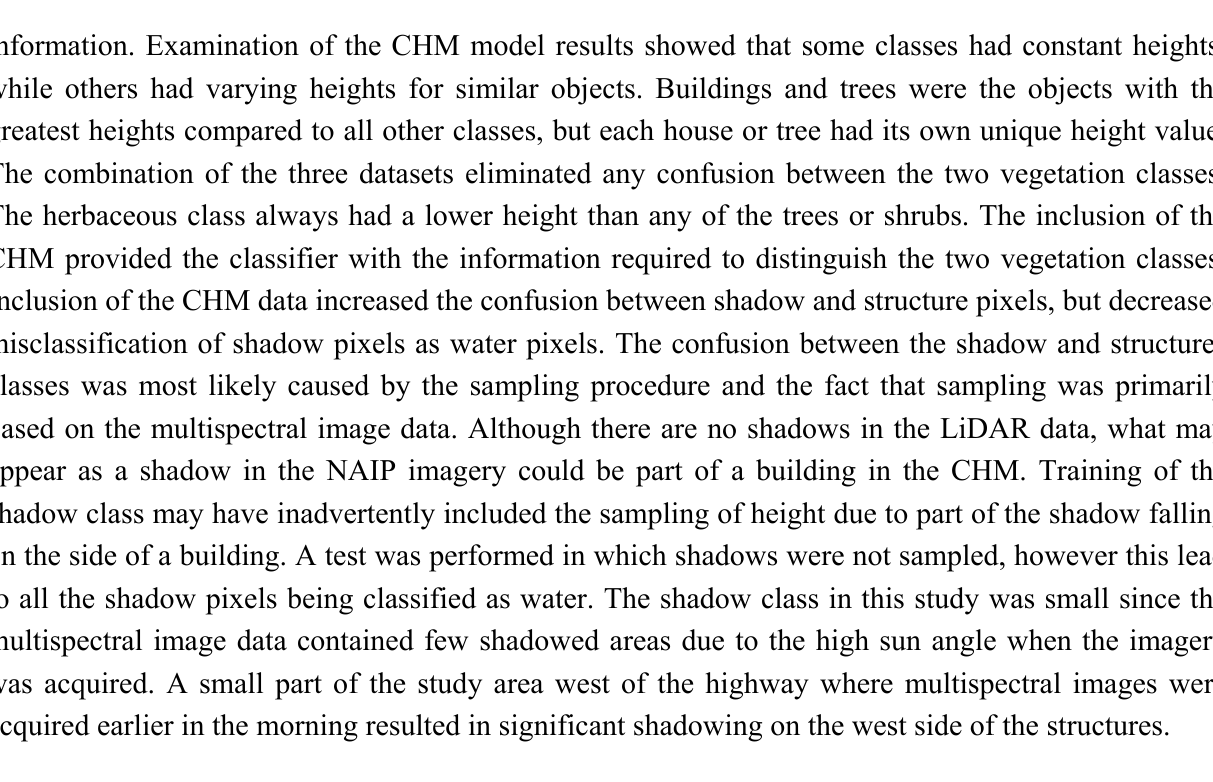
Table 3. Error matrix results for the classification performed with 2007 4-band NAIP data, NDVI data, and 2008 LiDAR CHM